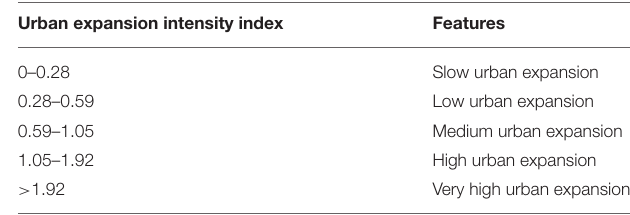
TABLE 1 | Classification of urban expansion according to urban expansion intensity index.